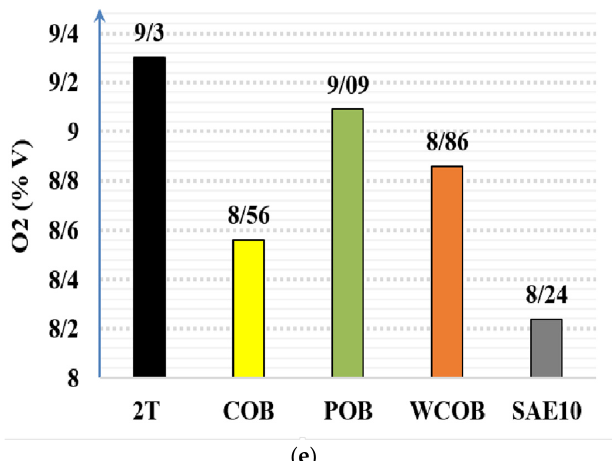
Figure 8. Mean values of engine emissions tests in different lubricant applications: ( a ) CO; ( b ) CO 2 ; ( c ) UHC; ( d ) NO x ; ( e ) O 2 .